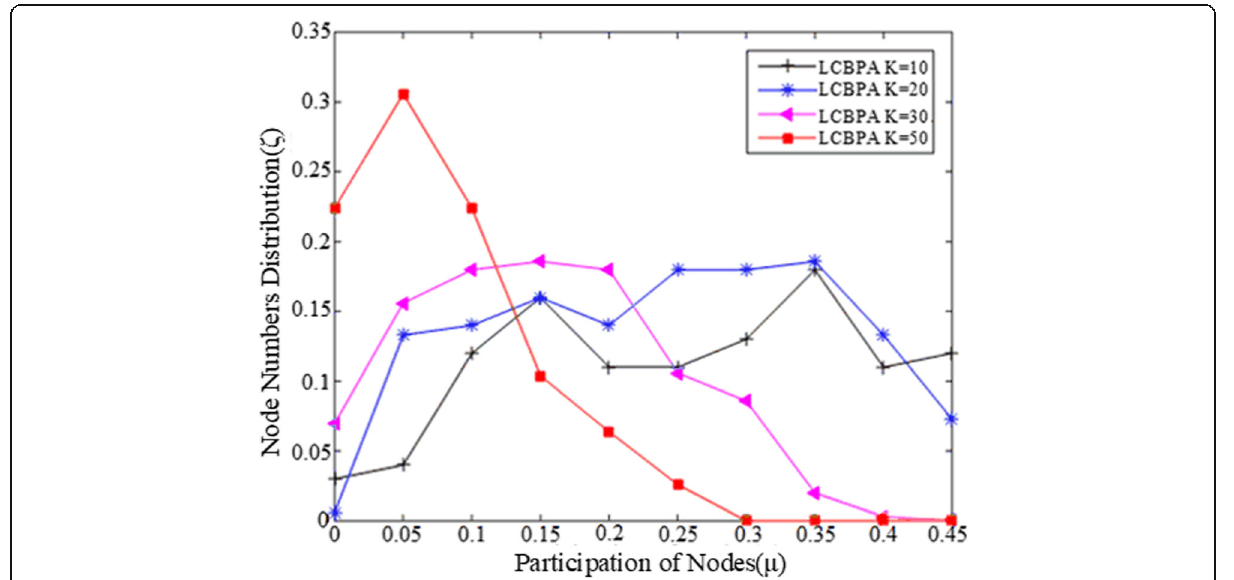
Fig. 9 Comparison of node participation equality of LCBPA with different sub-task number k when α = 0.5, N =300